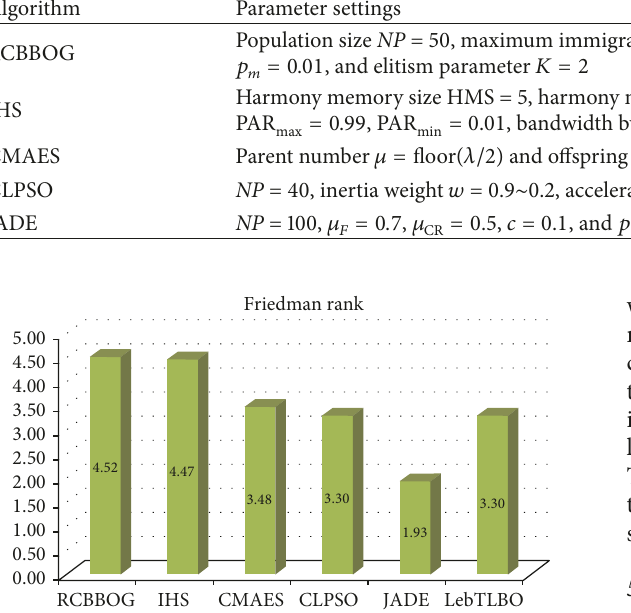
Figure 4: Friedman rankings of LebTLBO and other non-TLBO